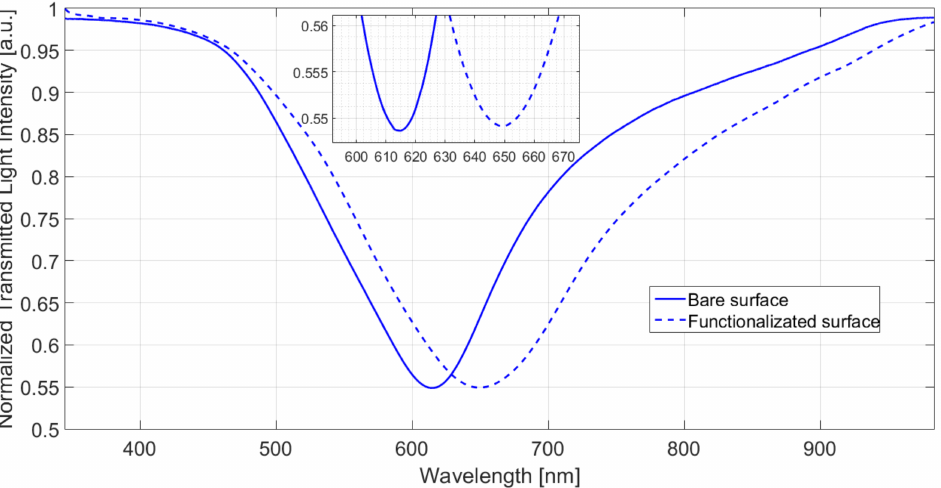
Figure 2. Normalized transmission spectra acquired using water as bulk, before (solid line) and after (dashed line) the nanoMIP’s functionalization.